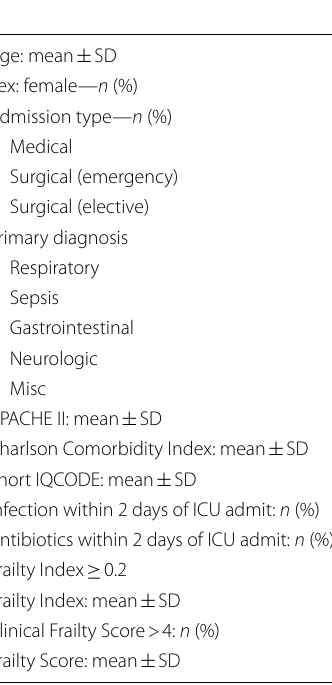
Table 1 Baseline characteristics